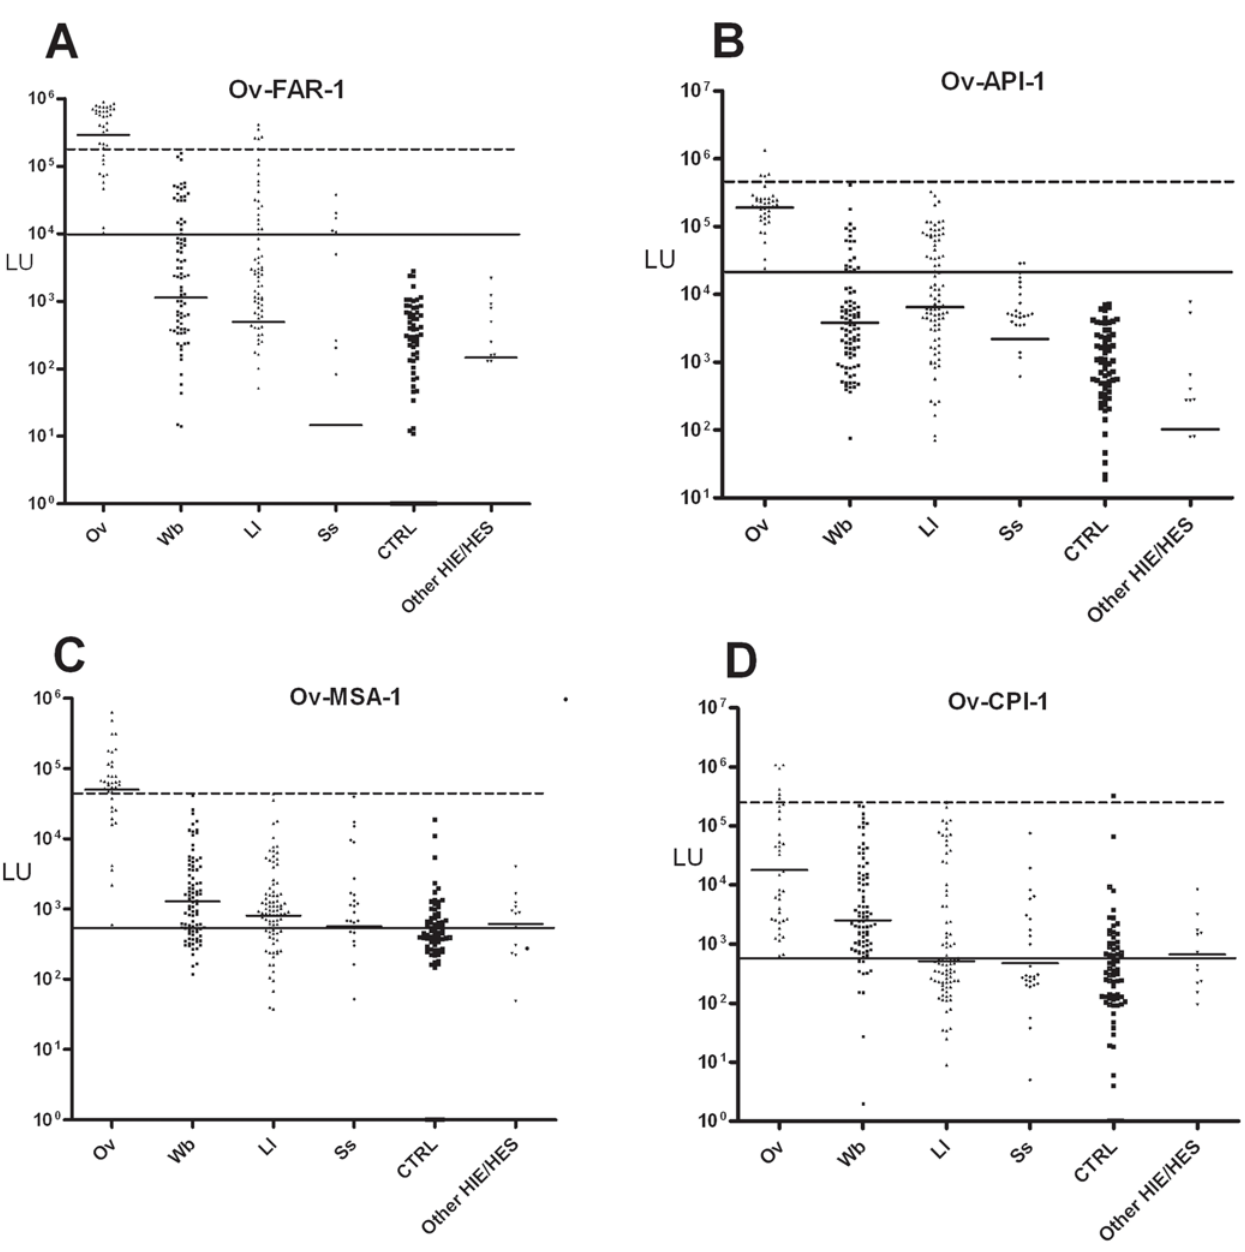
solid horizontal lines indicate the geometric mean titer (GMT) for each antibody per group. The diagnostic performance related to cross-reactivity with other filarial infections was also evaluated. As described in the text, the long solid line represents the cut-off level corresponding to 100% sensitivity, while the long stippled line corresponds to the cut-off for 100% specificity with sera from the Wb cohort.